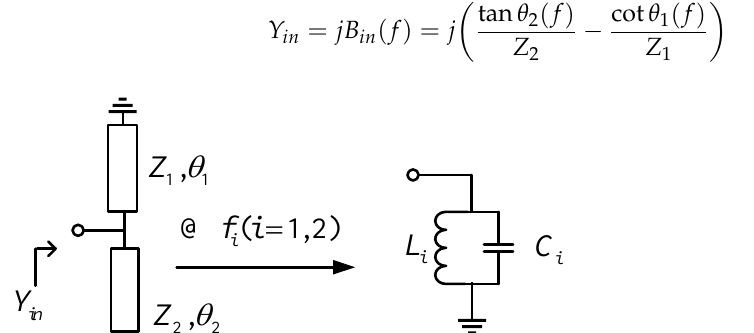
Figure 5. Structure of CSDMR and equivalent circuit.